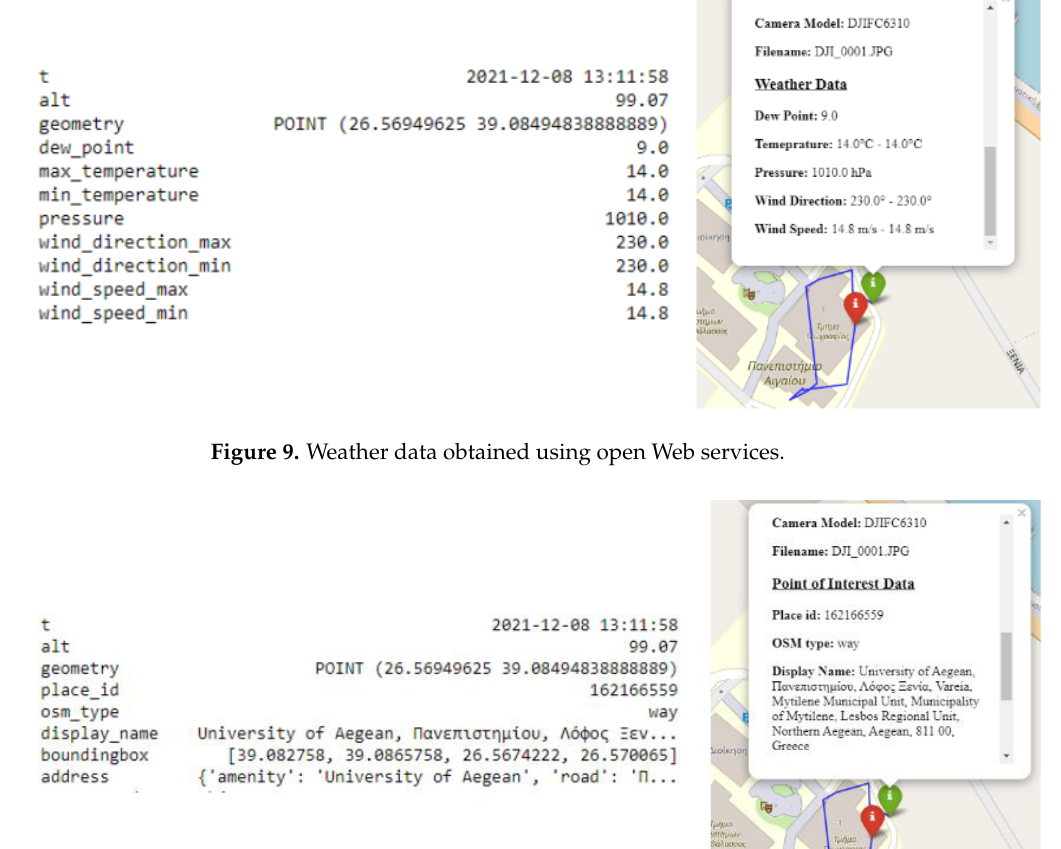
Figure 11. Trajectory segments based on distance.